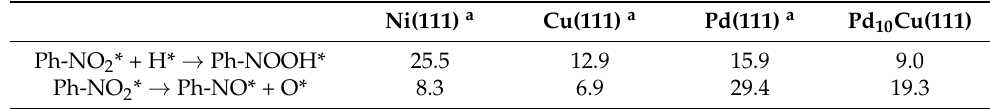
Table 4. Activation energies in kcal/mol for the first elementary step of each of the two pathways considered for nitrobenzene hydrogenation on different mono- and bimetallic catalyst